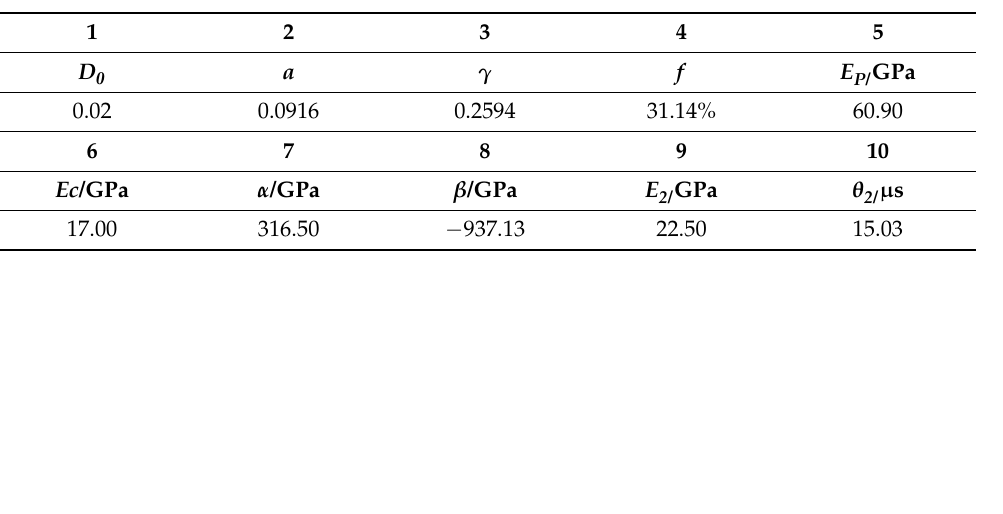
Table 1. Fitting results of parameters using experimental